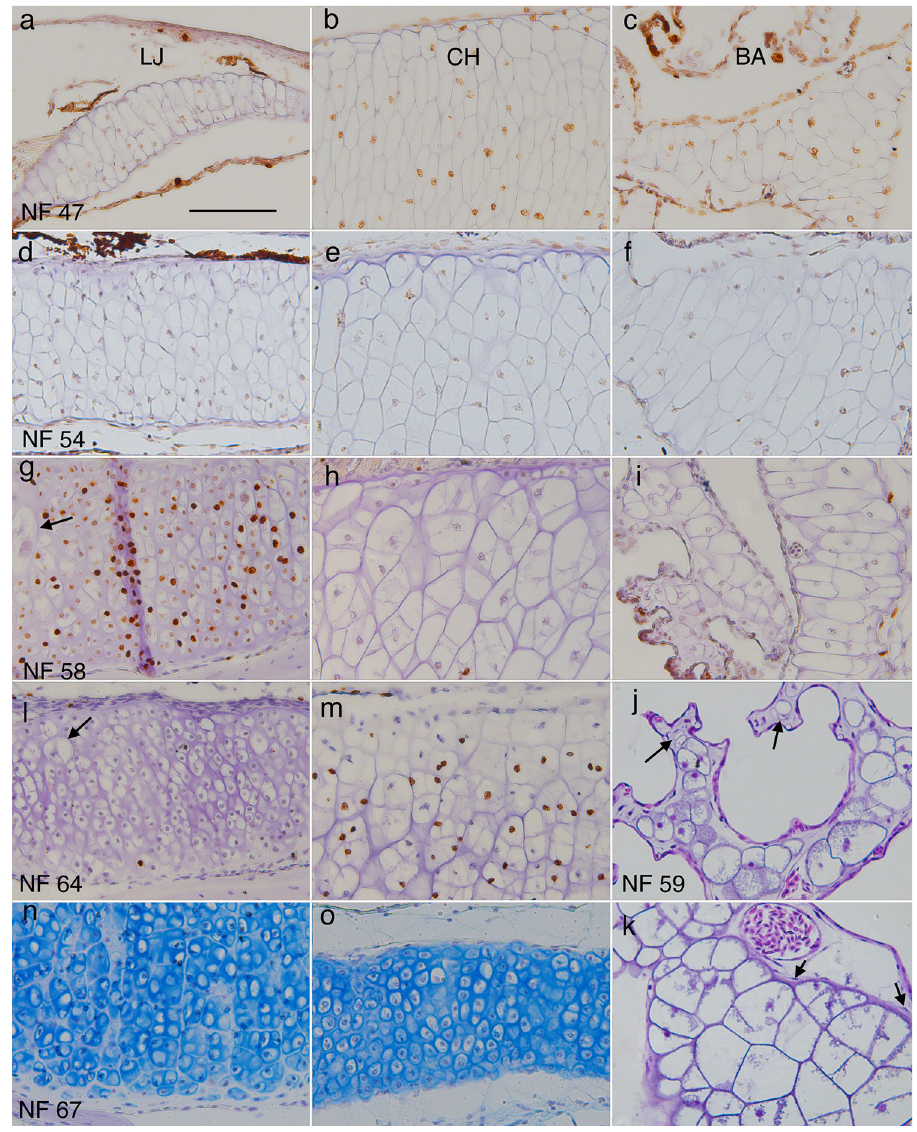
Fig 4. Representative sections of lower jaw (LJ), ceratohyal (CH) and branchial arch (BA) cartilages showing chondrocyte size, shape, arrangement, and matrix at different stages. (a-i, l-o) frontal, BrdU-labeled, hematoxylin or alcian blue-counterstained sections through middle portions of left LJ, CH and second ceratobranchial cartilages at NF 47, 54, 58, 64, and 67 (right is to the midline, up is anterior or lateral); arrows in g and l indicate large chondrocytes in the outer (more lateral) half of the cartilage. (j and k) transverse, resin-embedded, H&E-stained sections of branchial arch cartilages at NF 59. J shows an ornate process containing round chondrocytes of different sizes (arrows point to the smallest), capillaries, interstitial space, epithelia, and no perichondrium. K shows the transition from ceratobranchial base (lower right) to vertical rod (upper left), which is marked by a decrease in cell size, change from polygonal to more rounded cell outlines, and absence of perichondral cells (arrows) in the vertical rod. Scale bar is 0.1 mm. (ANOVA, p < 0.001), with the ceratohyal and branchial arch generally having the highest val- ues and the lower jaw the lowest (Fig 7A). Lower jaw chondrocytes peak at 28 μ m at NF 50–52, and then decrease slowly to 11–14 μ m at NF 62, when they level off. In contrast, ceratohyal and ceratobranchial chondrocytes peak at 50–52 μ m at NF 52, and stay above 39 μ m until NF